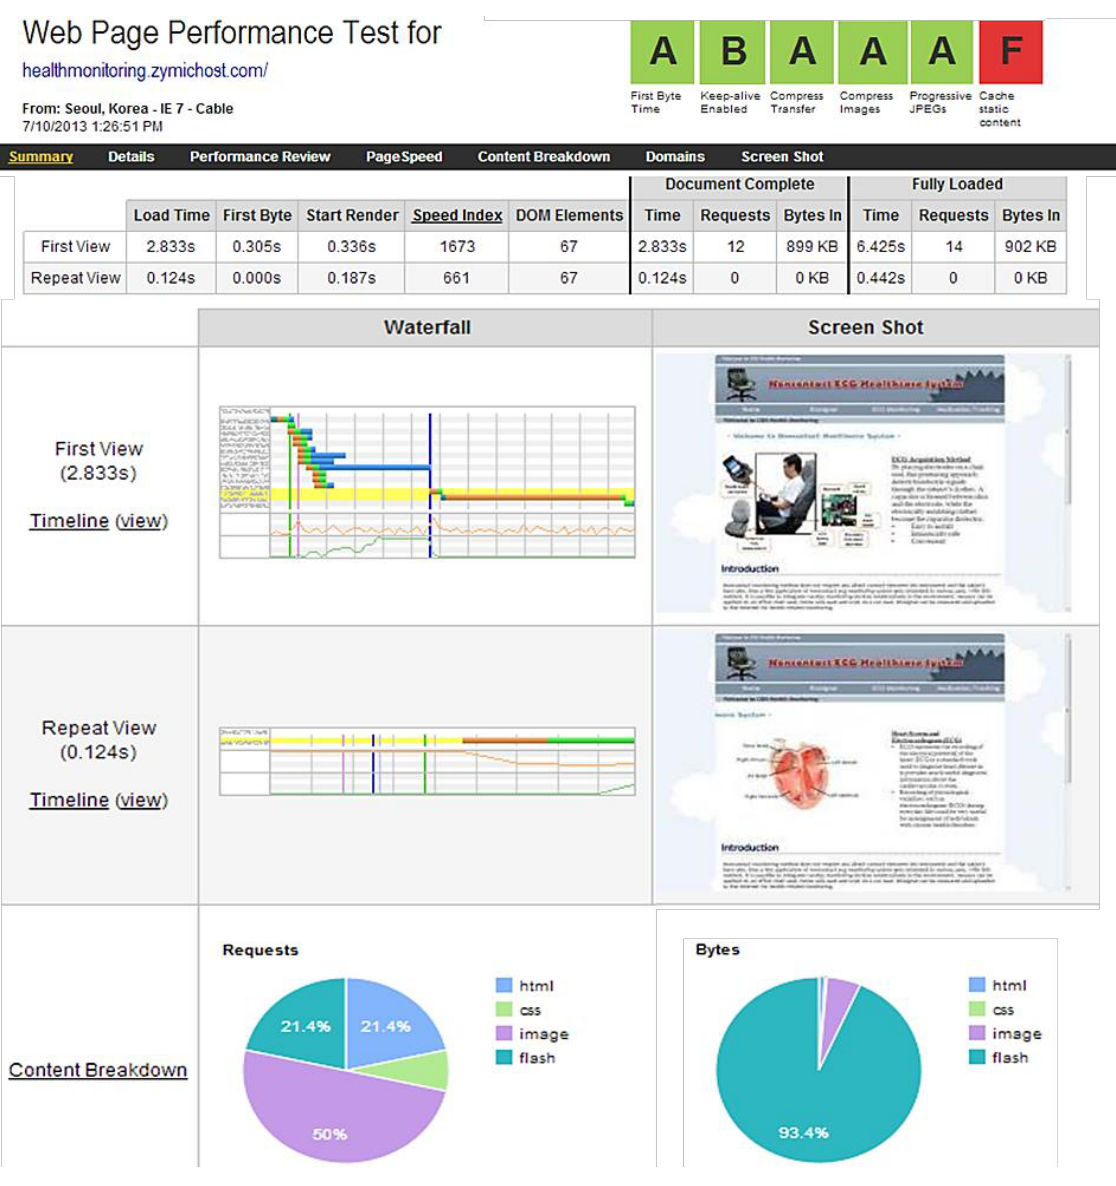
Figure 17. Web page performance evaluation